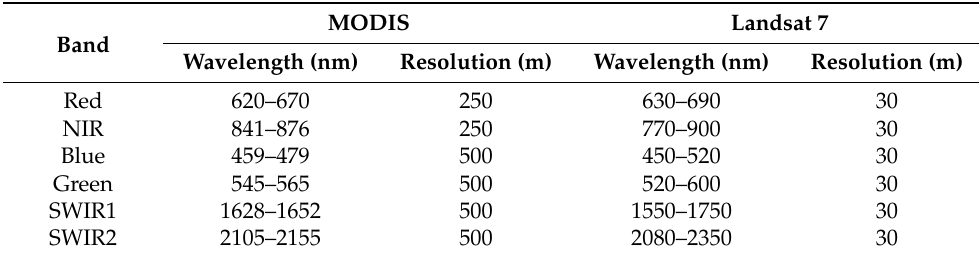
Figure 5. Training and predicting processes of the DRCNN in experiment 2. In the training process, the surface reflectance in the blue, green, SWIR1 and SWIR2 bands from the upsampled surface reflectance with a resolution of 1 km and the surface reflectance in the red and NIR bands from the preprocessed MOD09A1 product with a resolution of 500 m were employed as the input of the DRCNN, and the surface reflectance in the blue, green, SWIR1 and SWIR2 bands from the preprocessed MOD09A1 product were utilized as the output of the DRCNN. In the prediction process, the surface reflectance in the blue, green, SWIR1 and SWIR2 bands from the preprocessed MOD09A1 product with a resolution of 500 m and the surface reflectance in the red and NIR bands from the preprocessed MOD09Q1 product with a resolution of 250 m were entered into the DRCNN to generate 250 m surface reflectance in the blue, green, SWIR1 and SWIR2 bands. In this study, the downscaled surface reflectance at 250 m resolution were compared with the surface reflectance of the MOD09A1 product and the downscaled surface reflectance by the bicubic interpolation method and the ESPCN method. For the time series analysis, we introduce the surface reflectance of Landsat 7 as reference data to evaluate the downscaled surface reflectance at 250 m resolution. The Landsat 7 has provided many years of global surface reflectance since its successful launch in 1999. The band specifications of Landsat 7 along with MODIS are shown in Table 1. Table 1. Band specifications for MODIS and Landsat 7.